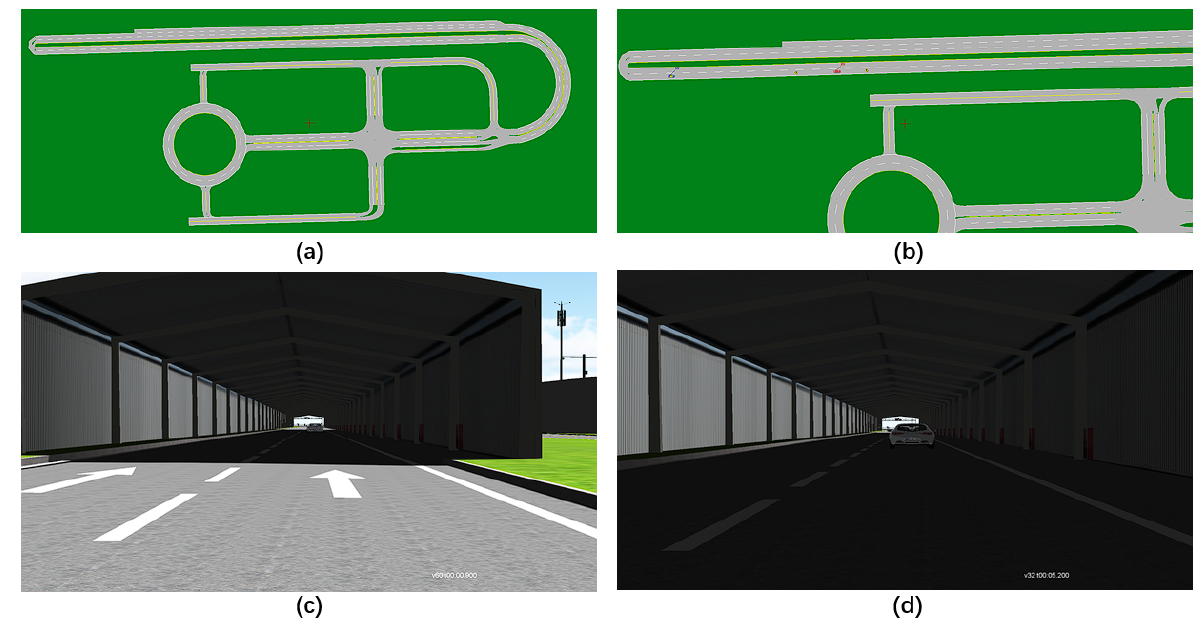
Figure 9. ( a ) Closed test field map in OpenDRIVE Odr Viewer. ( b ) OpenSCENARIO editing interface for forward collision warning test scenarios in VTD simulator. ( c ) Effect of forward collision warning test (HV’s speed = 60 km/h time = 0.9 s) in VTD simulator. ( d ) Effect of forward collision warning test (HV’s speed = 32 km/h time = 5.2 s) in VTD